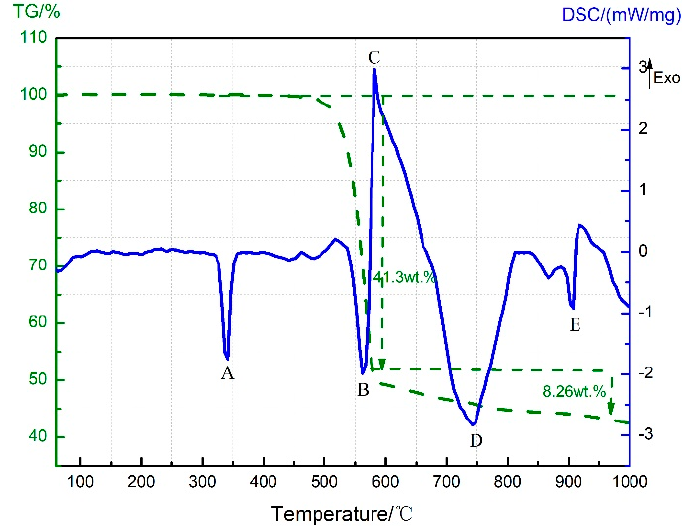
Figure 7. TG-DSC curve of PTFE/MnO 2 .